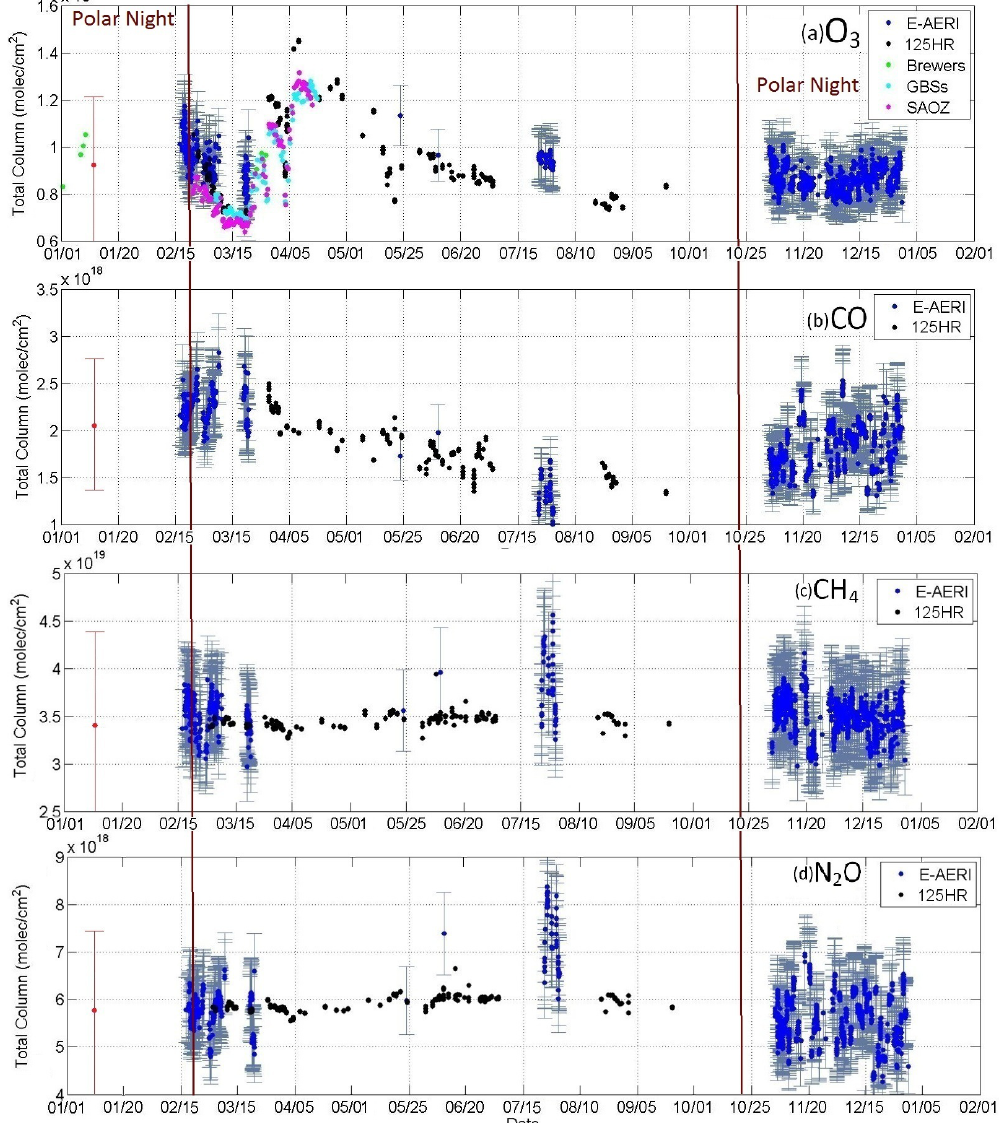
Fig. 7. Same as in Fig. 3, except for 2011. The E-AERI was located at 0PAL (10m altitude) and retrieved total columns are from 0.61 to 100km, while the other spectrometers were located at the PEARL Ridge Lab (610m altitude). The a priori column is shown for one day (red) with error bars corresponding to the diagonal of S a . Polar night is indicated outside the brown vertical